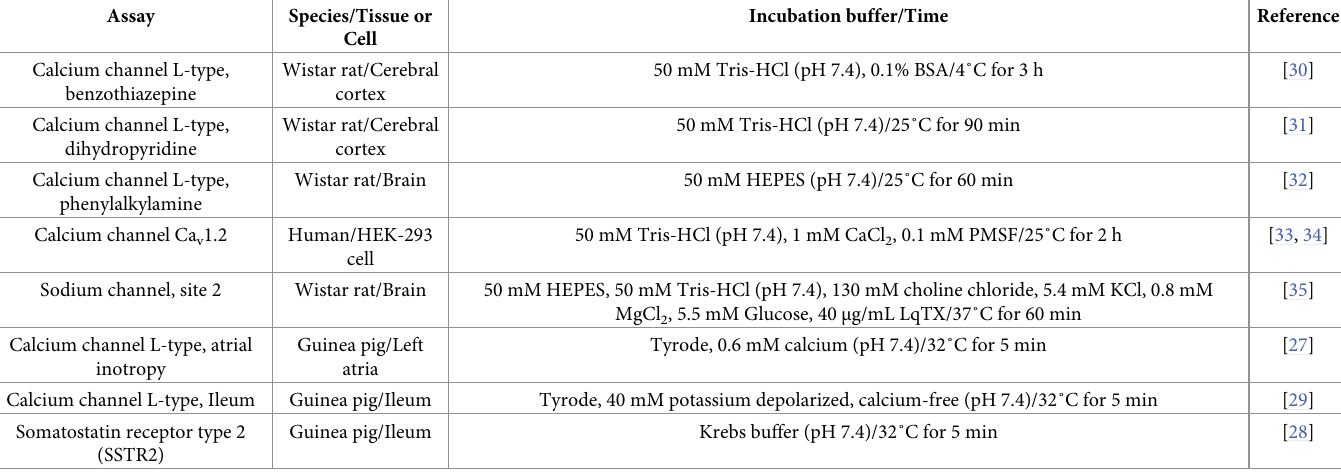
Table 1. R-Vera and S-Vera test systems in in vitro radioligand binding and tissue assays. Assay Species/Tissue or Cell